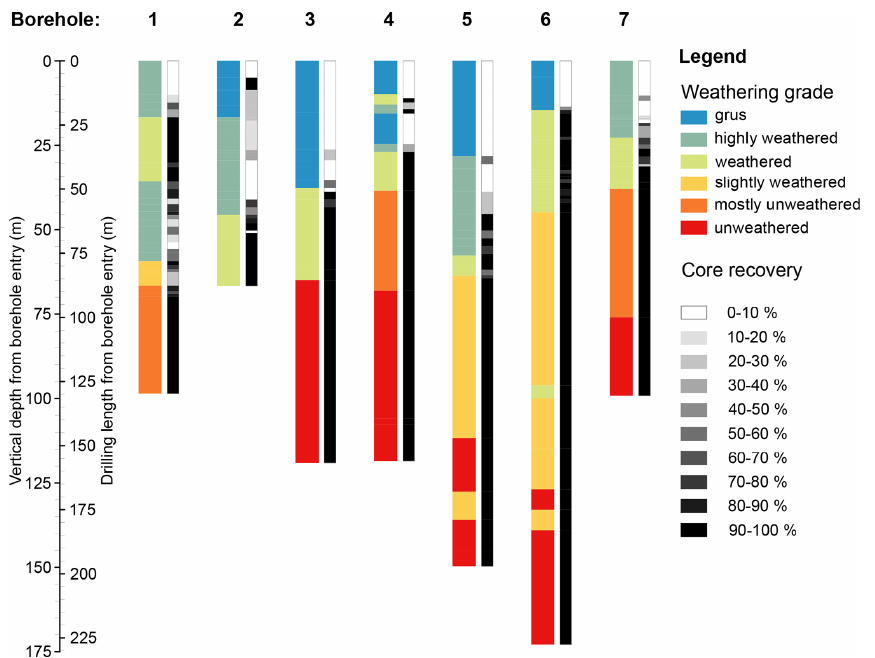
Figure 3. Geological boreholes drilled by the Commissariat à l’Energie Atomique, showing the granite weathering grade and the core recov- ery percentage. The borehole locations are shown in Fig. 1. The “highly weathered” and “weathered” layers were interpreted as corresponding to the fissured layer, while the “slightly weathered” to “unweathered” layers were interpreted as corresponding to the